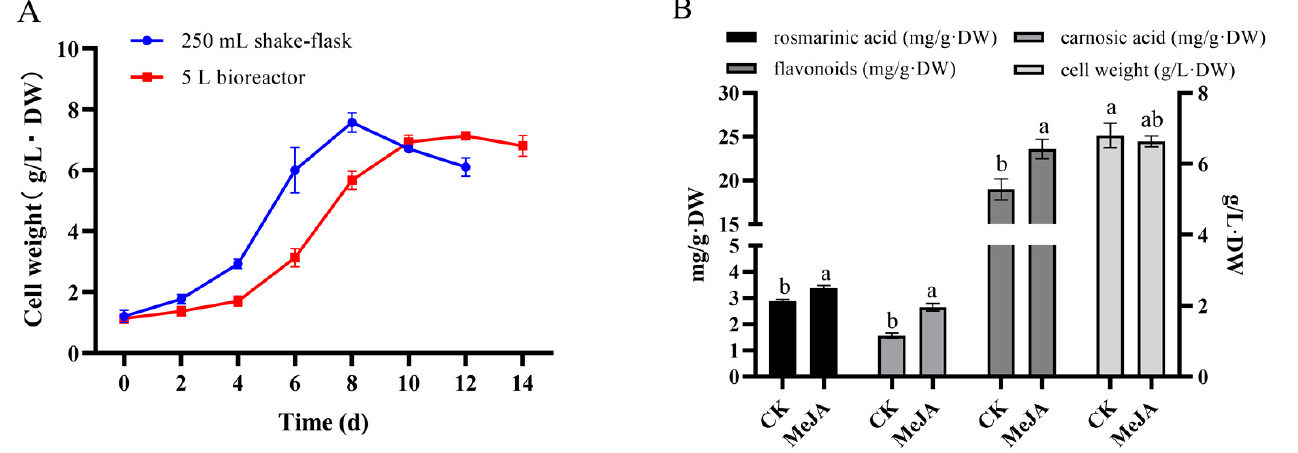
Figure 8. Amplification culture of rosemary suspension cells in 5 L stirring bioreactor. ( A ) Changes in the cell growth between the stirred bioreactor and shake flask; ( B ) The effects of MeJA on the rosemary suspension cells in 5 L stirred bioreactor. Different letters above the bars respectively in- dicate a significant difference ( p < 0.05) among the CK and MeJA treatment.